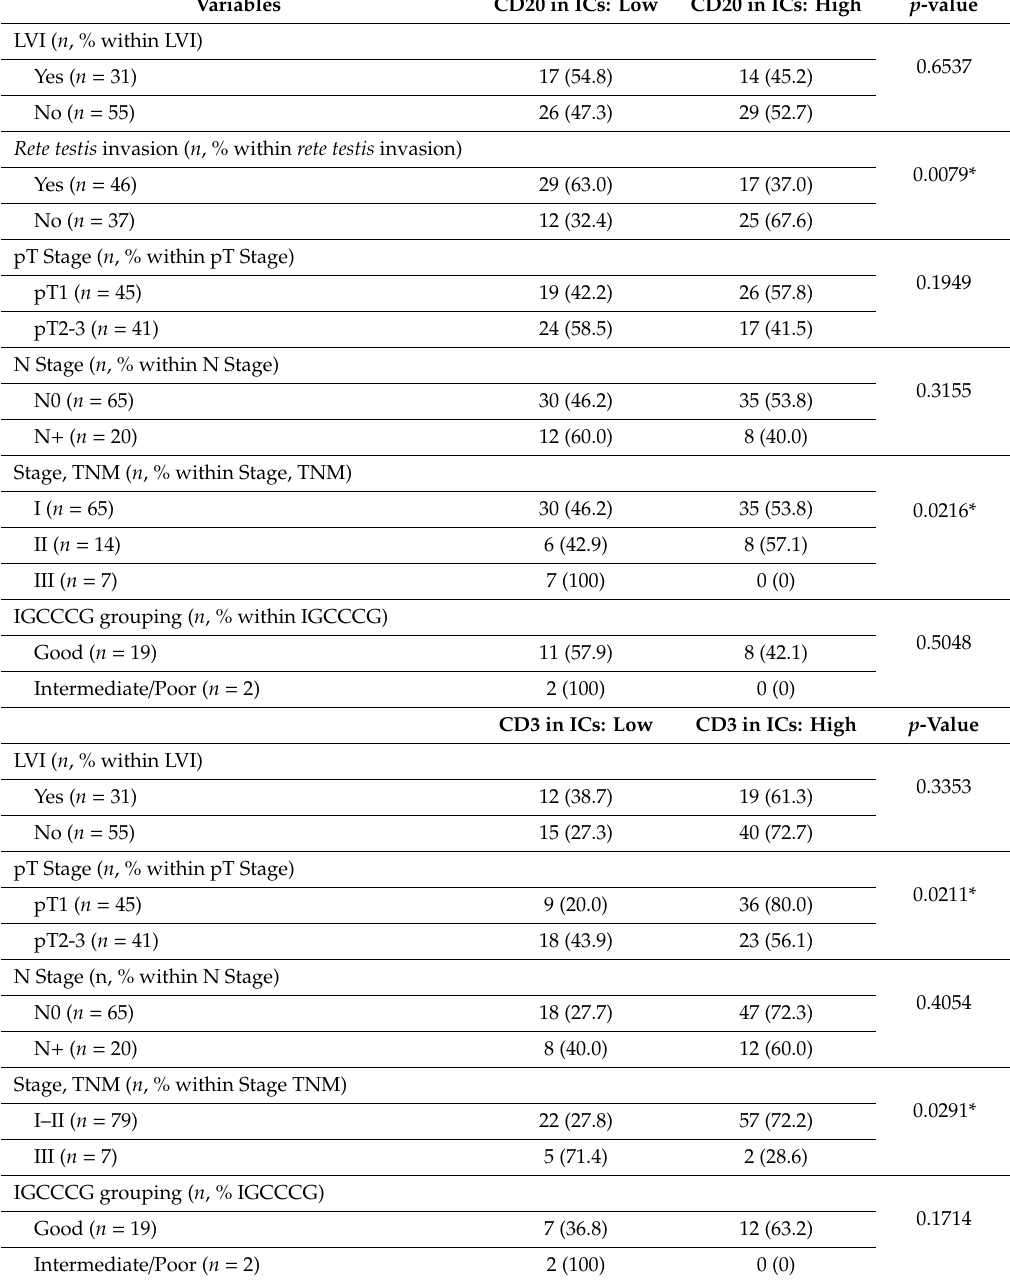
Table 4. Association between CD20 and CD3 immunoexpression in immune cells populating seminomas and clinicopathological